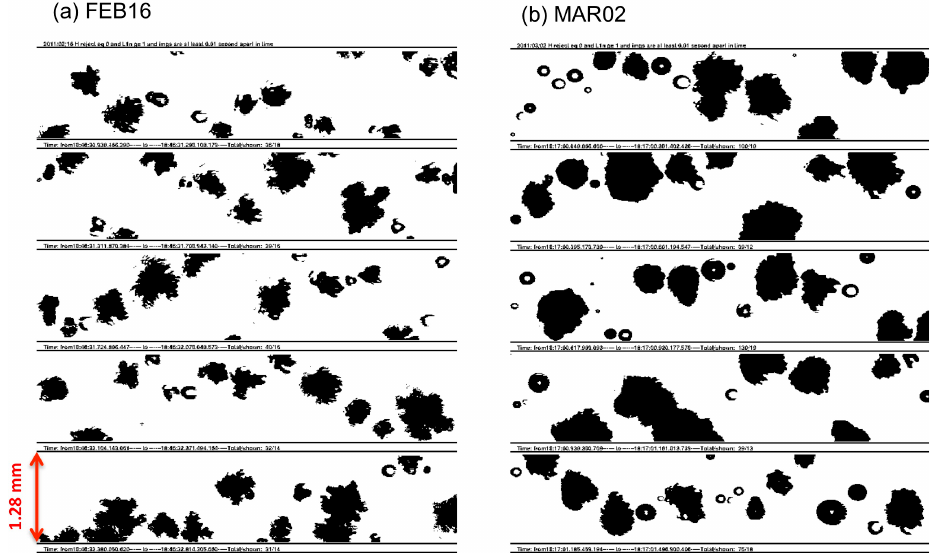
Fig. 2. Images of 2DS for cloud hydrometeors in (a) FEB16 and (b) MAR02 at 18:46:30UTC on 16 February and 18:17:00UTC on 2 March, respectively.